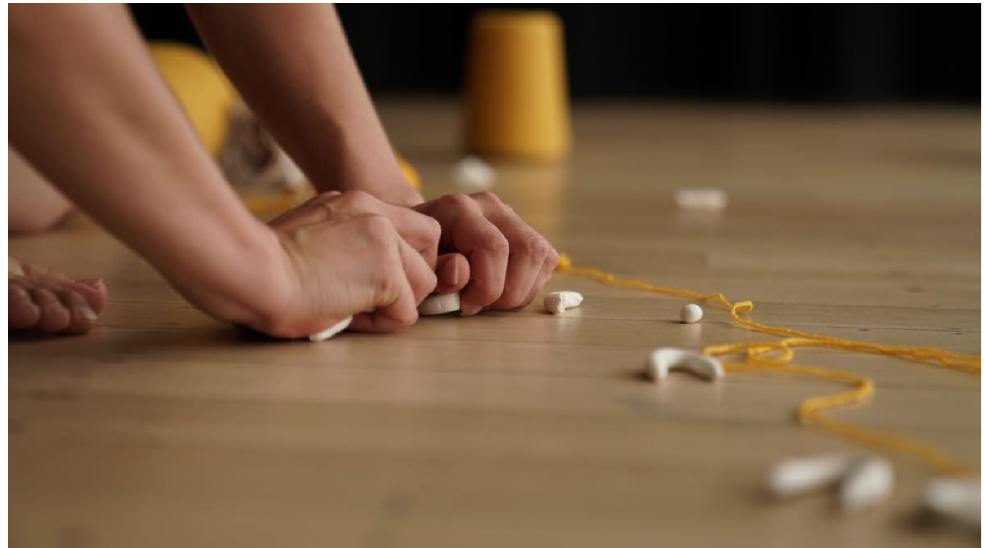
Figure 2: Joanna Cook, Fragments of Silent Skin, 2020 Photographer Yin Chi